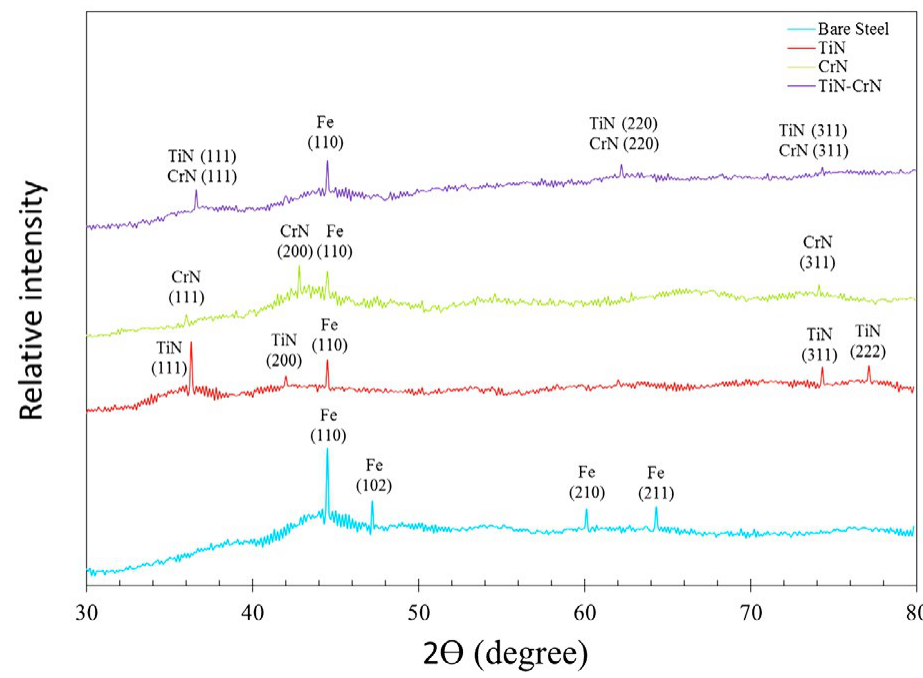
Fig. 2. XRD patterns of the